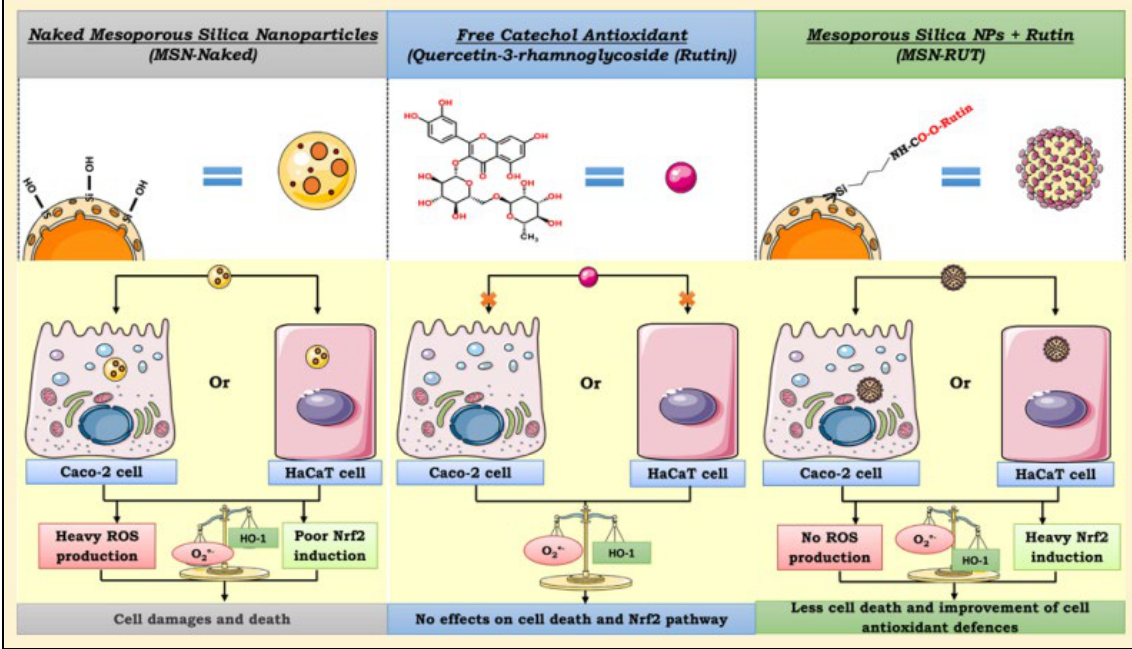
Figure 10. ROS generation, Nrf2 activation, and cell death are all affected by free catechol antioxidant (Rutin), naked MSNs, and MSNs-RUT.